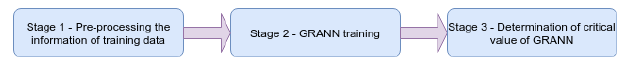
Figure 2. Stage one, automatization process of GRANN